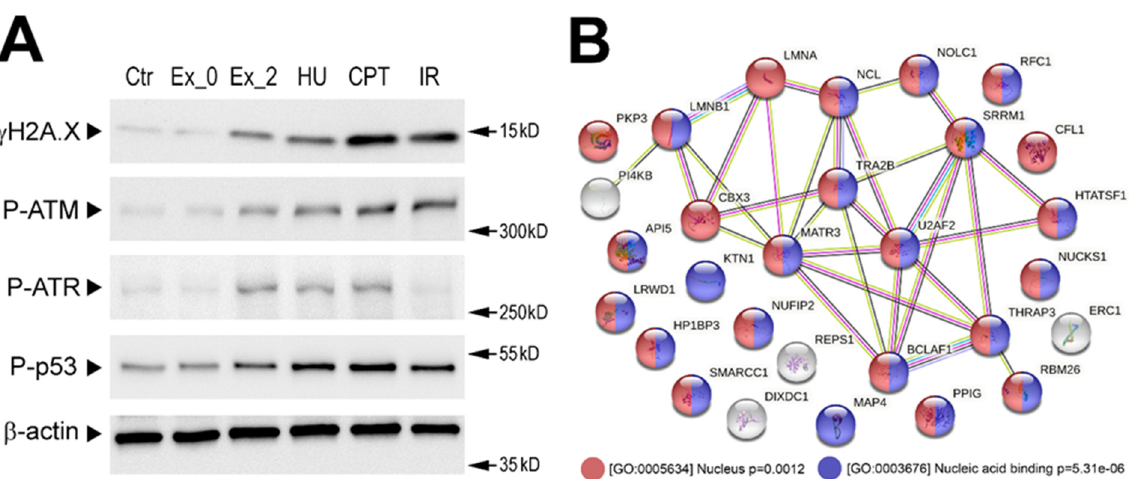
Figure 3. Exosome-stimulated changes in the phosphoproteome of the recipient cells. ( A ) Phosphorylation of selected DNA damage-related proteins analyzed by Western blotting. FaDu cells were stimulated with exosomes released by sham-irradiated (Ex_0Gy) or irradiated (Ex_2Gy) cells, hydroxyurea (HU), and camptothecin (CPT) or directly irradiated with 2 Gy (IR); β -actin was used as a loading control (raw Western blot images are available in Figure S1). ( B ) Network of putative interactions between proteins phosphorylation which was induced in FaDu cells after one hour of stimulation with Ex_2Gy vesicles; color-coded are the proteins associated with two selected GO terms: nuclear localization and nucleic acid binding function ( p -value refers to the significance of the term overrepresentation).